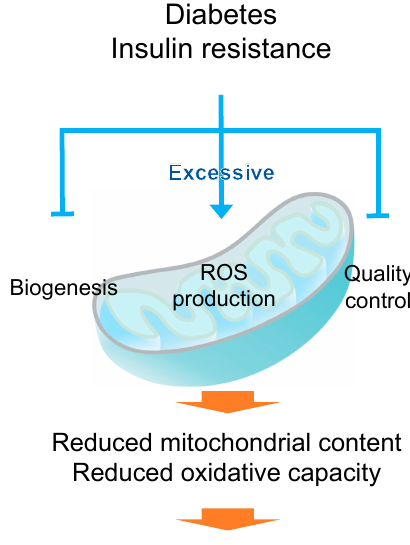
Schematic representation of mitochondrial dysfunction in diabetic skeletal muscle. Skeletal muscle contains a large volume of mitochondria that produce energy for biological activity. Diabetes mellitus induces mitochondrial dysfunction, including decreased biogenesis, impaired quality control (e.g., fusion, fission and mitophagy), and excessive ROS production in skeletal muscle, leading to the reduction in mitochondrial content and oxidative phosphorylation.